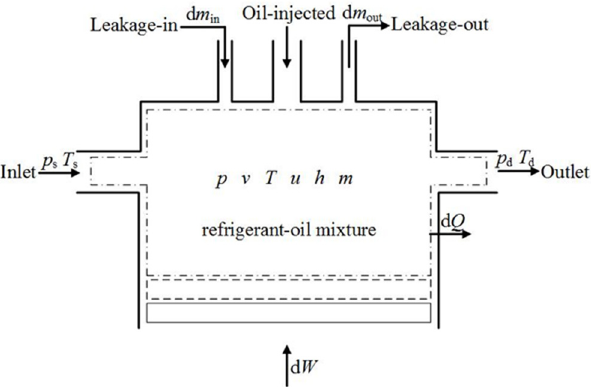
Figure 3. Schematic of the control volume of the twin screw compressor in the compression pro-